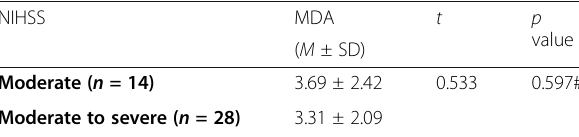
Table 2 Relation between NIHSS and malondialdehyde in ischemic stroke patients